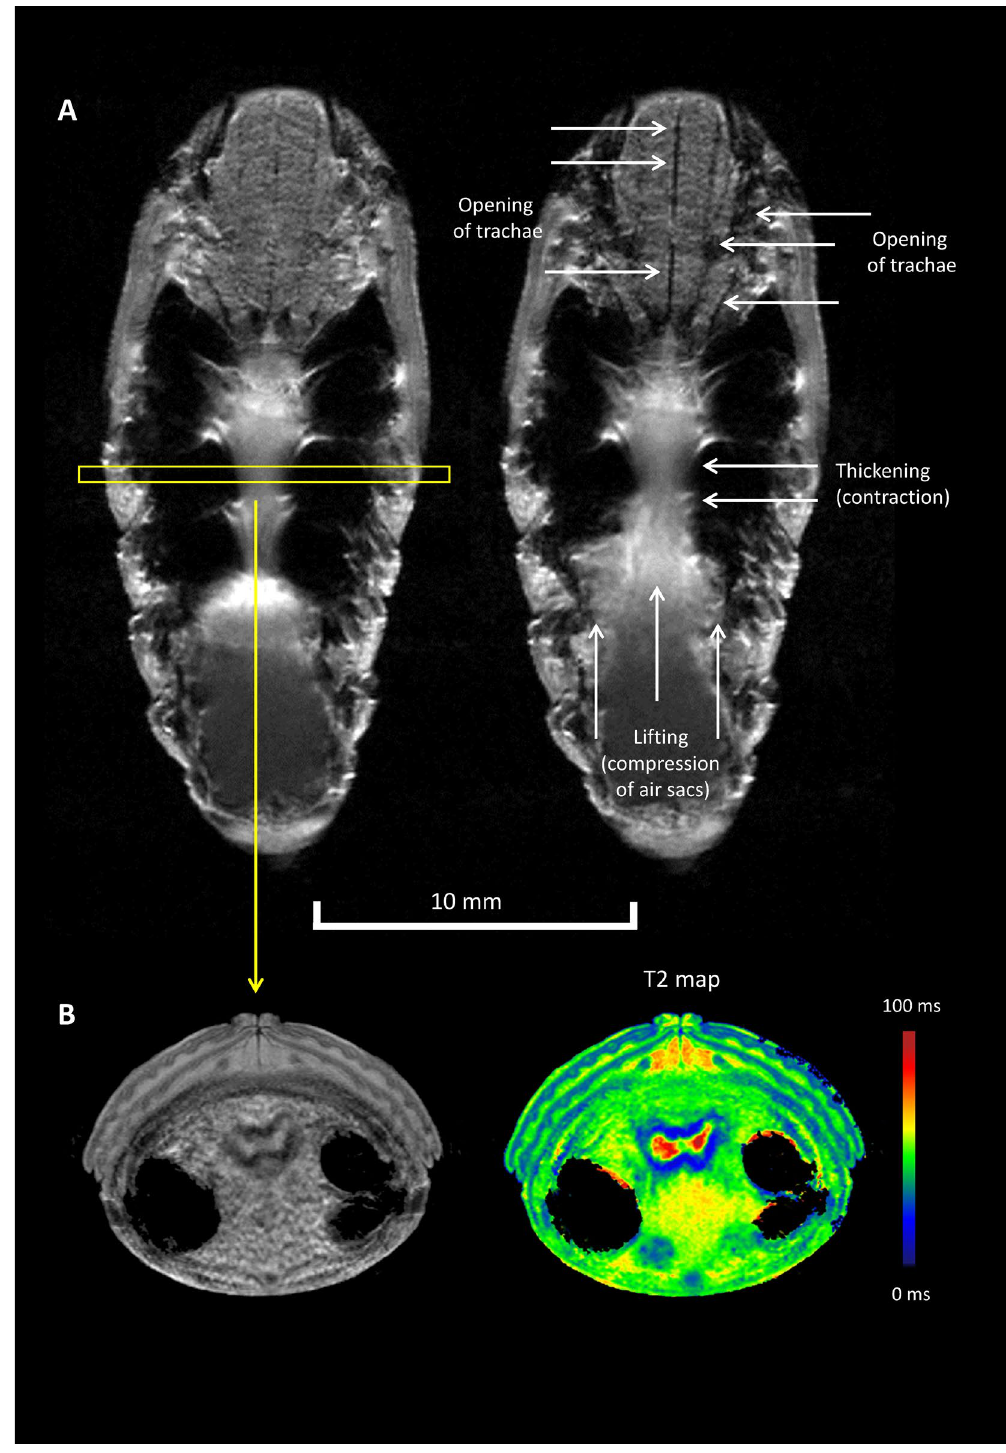
Figure 4. Visualization of active ventilation. ( A ) Sequential coronal sections illustrate air sac compression by contraction and lifting of the abdominal tract leading to opening of tracheae allowing active ventilation. The yellow rectangle indicates the imaging plane in ( B ). ( B ) Axial sections relating anatomy and MR relaxometry indicating typical muscle T2 relaxation times around the contracting gut (colour-encoded in